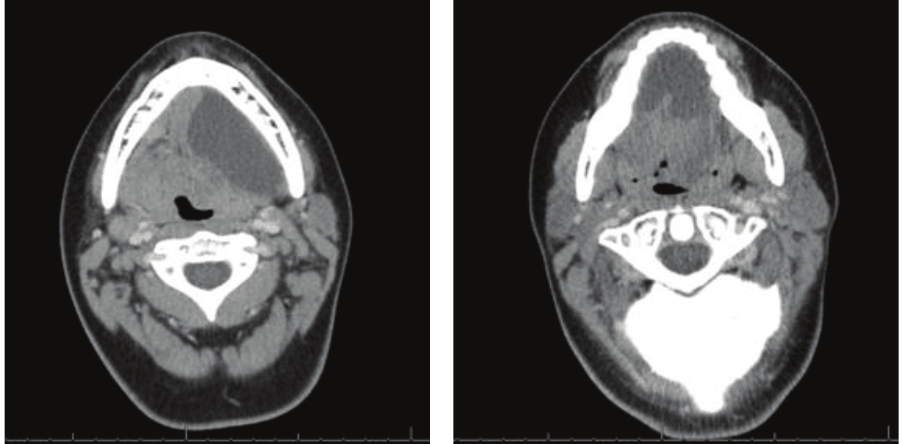
Figure 1: CT scan with IV contrast revealing a fluid filled, unilocular sac with extension across the midline and into the submandibular space.